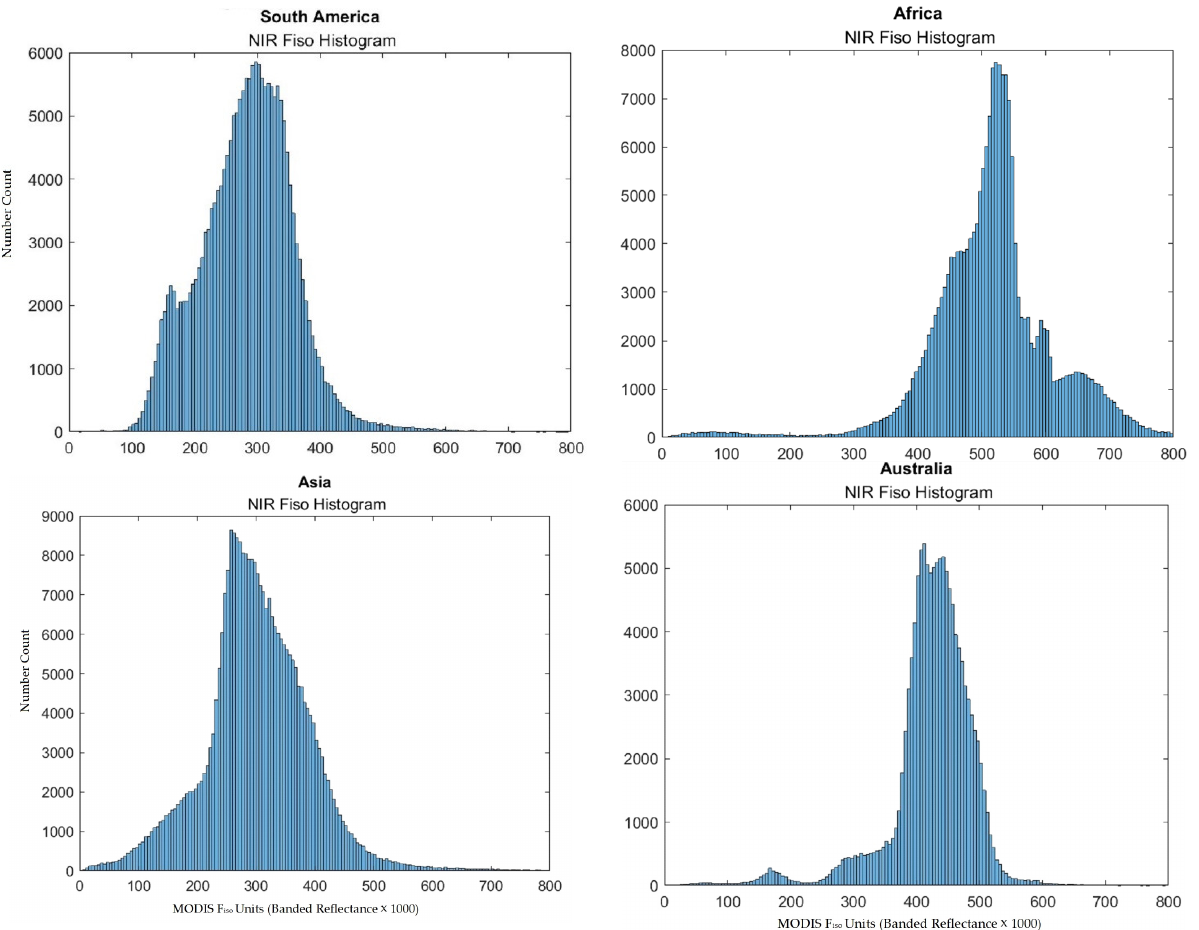
Figure 6. Banded NIR reflectance of barren classified pixels across Africa, South America, Australia, and Asia in MODIS units (reflectance × 1000). Note there are three distinct peaks in the histogram, which are continent dependent.